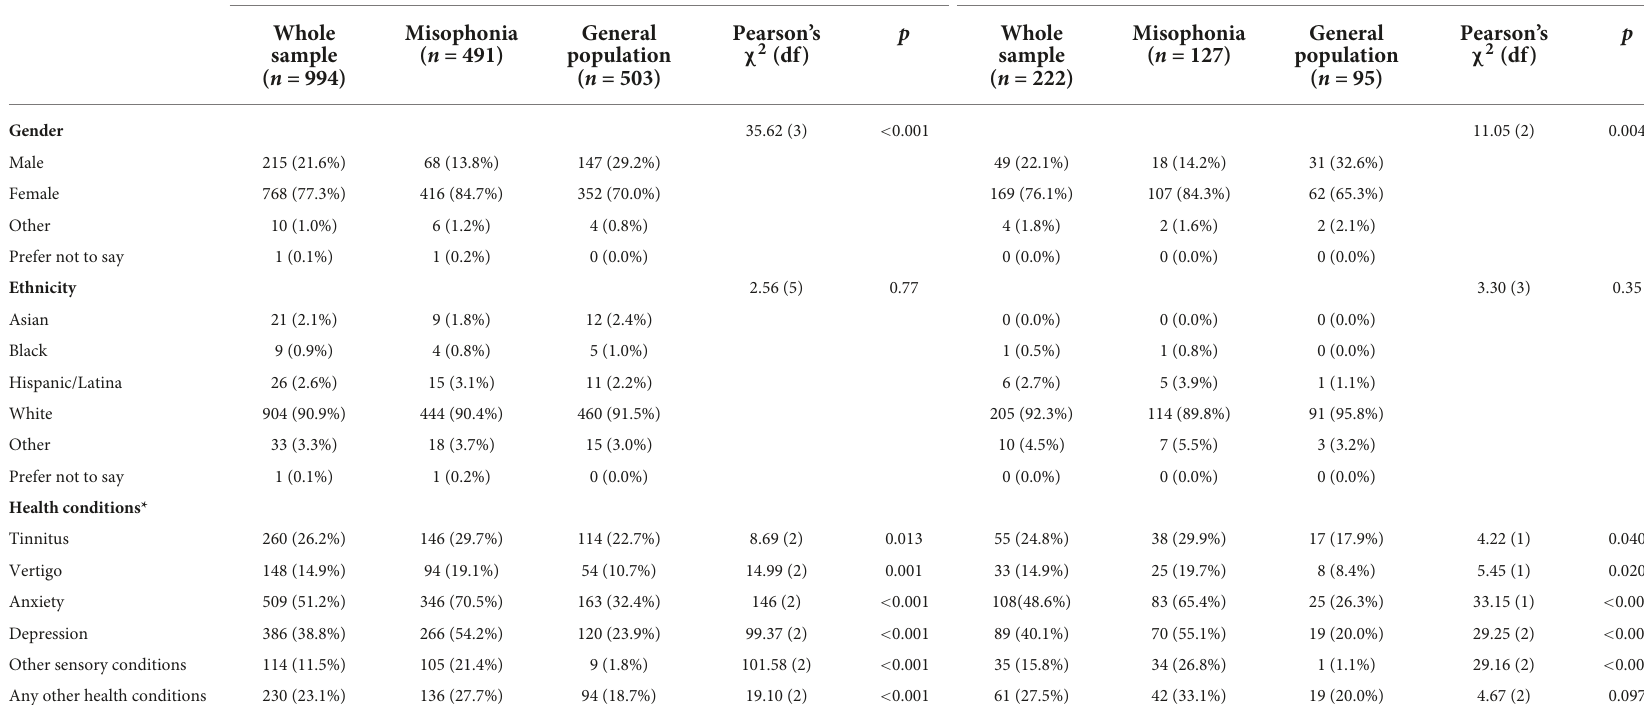
TABLE 2 Participants’ demographic